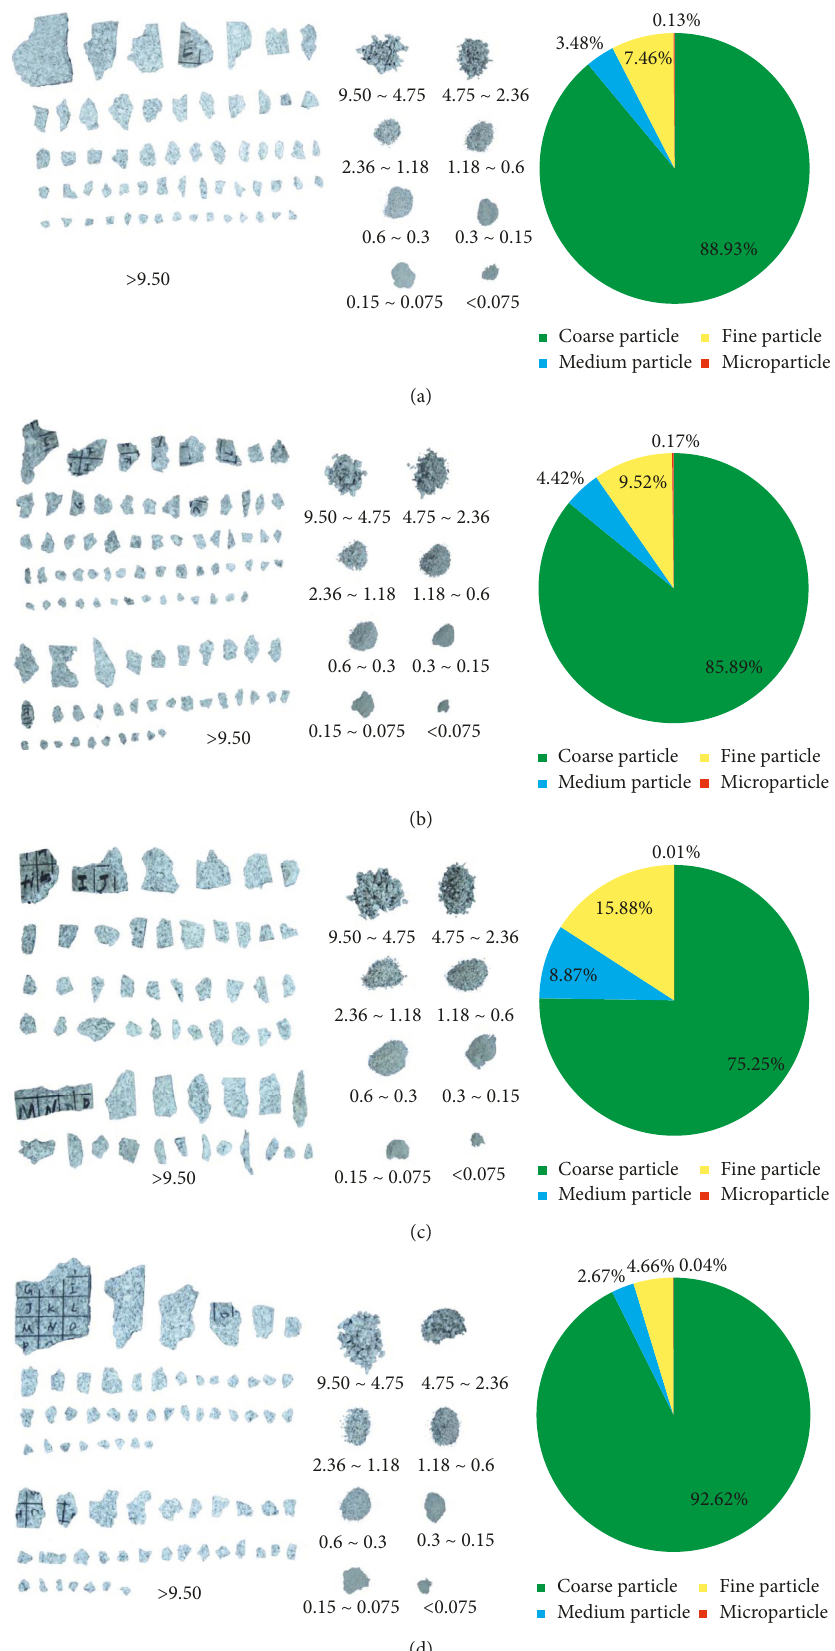
Figure 21: The size distribution of the fragments for different support failure rates (unit: mm): (a) v (c) v 1.0MPa/s; (d) v (cid:31) (cid:31)